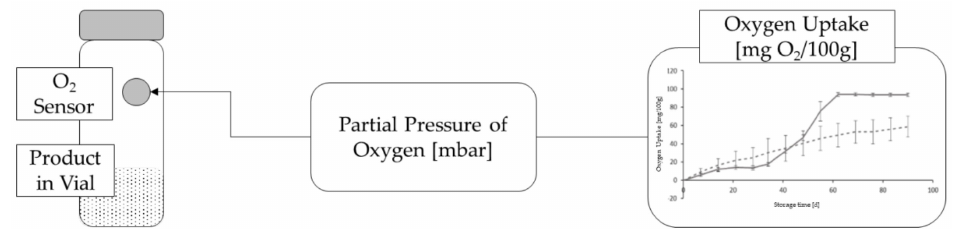
Figure 1. Scheme for experimental setup for measuring the oxygen uptake of emulsions during an accelerated storage